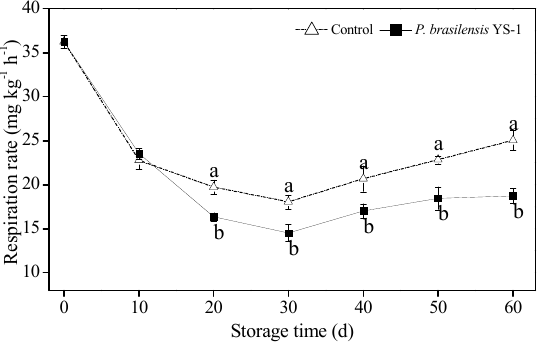
Figure 3. Effect of P. brasilensis YS-1 treatment on the respiration rate of citrus fruits stored at 5 ± 0.5 °C for 60 d. Vertical bars represent the mean ± SE (n = 3). Letters indicate statistical differences according to an independent samples t -test ( p < 0.05) on each storage day.